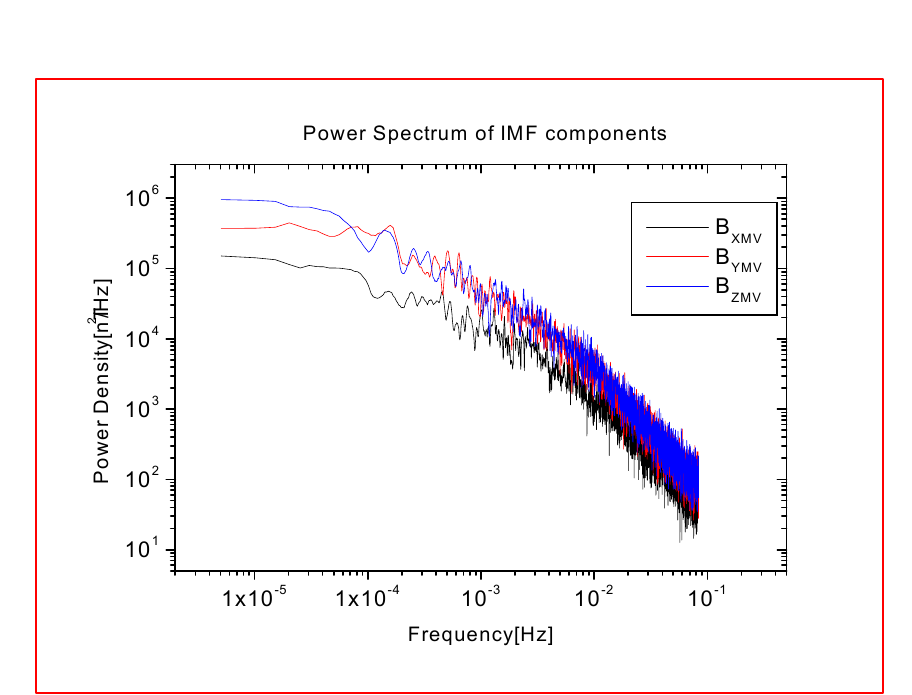
Figure 31: Power density spectra of the three components of IMF after rotation into the minimum variance reference system. The black curve corresponds to the minimum variance component, the blue curve to the maximum variance, and the red one to the intermediate component. This case refers to fast wind observed at 0.3 AU and the minimum variance direction forms an angle of ∼ 8 ∘ with respect to the ambient magnetic field direction. Thus, most of the power is associated with the two components quasi-transverse to the ambient